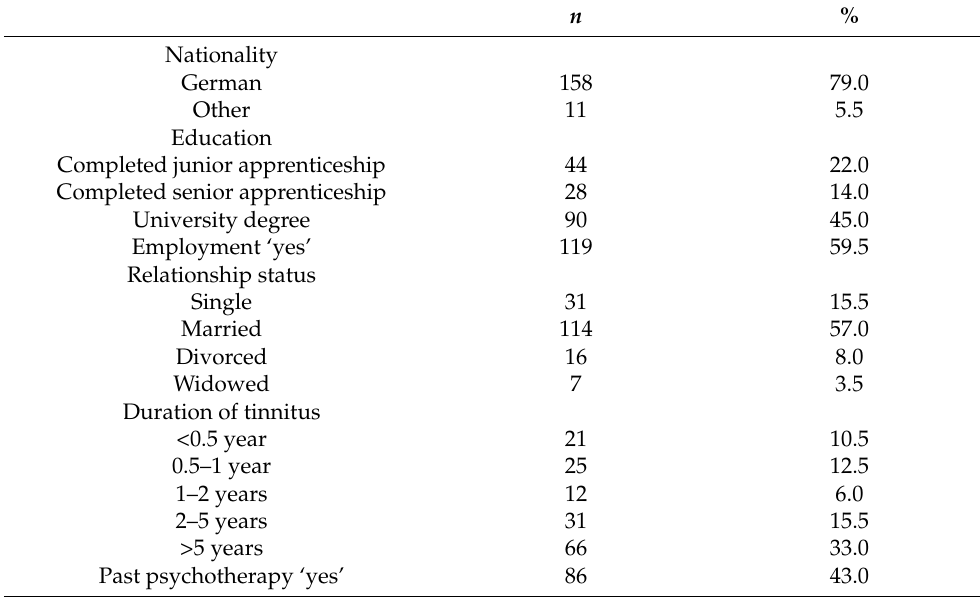
Table 1 features an overview of the sociodemographic information. Table 1. Sociodemographic data and patient characteristics ( n = 169).